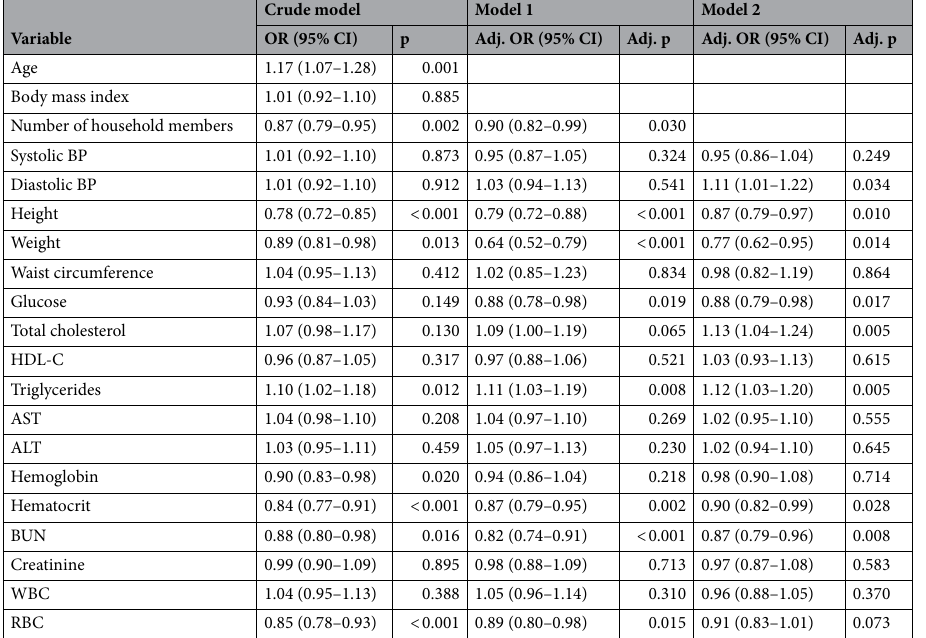
Table 2. Association of depression disorder with biochemical and anthropometric indices in men. HDL-C high-density lipoprotein cholesterol, AST aspartate aminotransferase, ALT alanine aminotransferase, BUN blood urea nitrogen, WBC white blood cell, RBC : red blood cell. Crude Model: unadjusted model, Model 1: adjusted for age and BMI, Model 2: adjusted for age, BMI, income, education, occupation, number of household members, marital status, stress, smoking, and alcohol